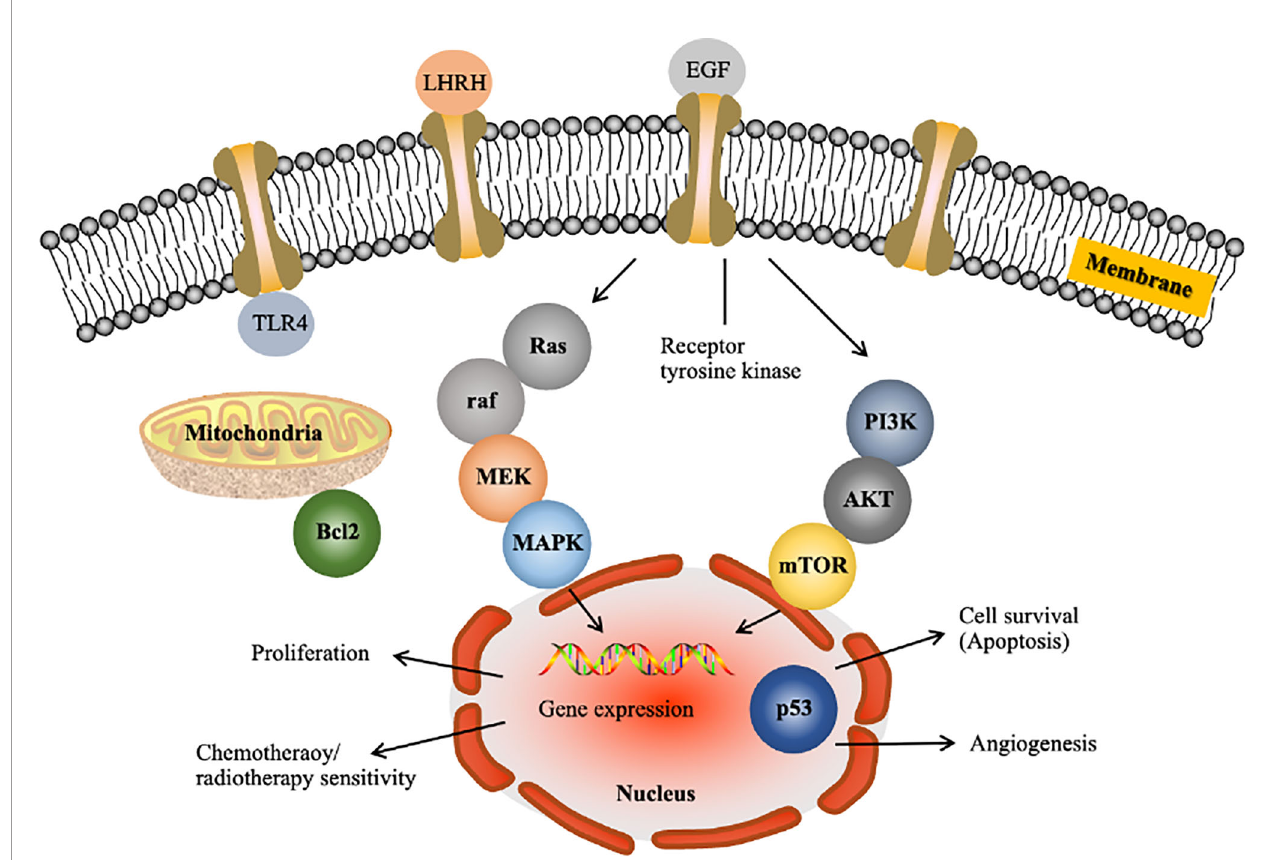
FIGURE 1 | Examples of molecular targets in tumor cells for liver cancer drug development. LHRH, luteinizing hormone releasing hormone; EGF, epidermal growth factor; TLR4, Toll-like receptor 4; MAPK, mitogen-activated protein kinase. The fi gure shows the following two major pathways implicated in HCC: the Raf/MEK/Erk pathway, which is the prototypical MAPK cascade (35), and the PI3K/Akt/mTOR pathway